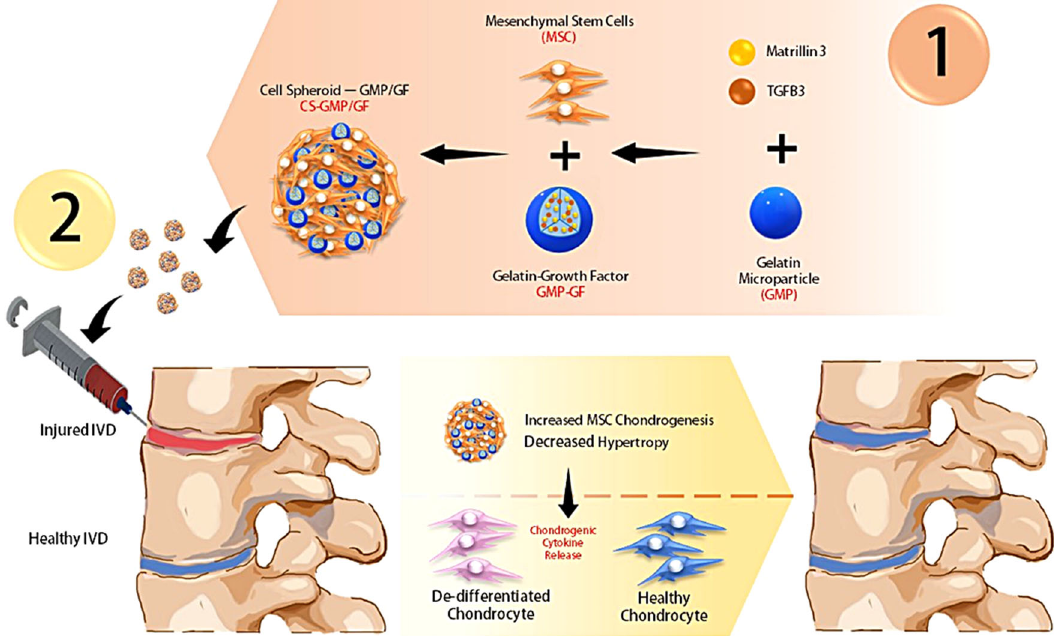
Fig. 1 Research summary. Incorporation of TGFB3 and Matrilin-3-loaded gelatin microparticle (GMP) in ASC spheroids enhances chondrogenic differentiation of cells, inhibits hypertrophy, and promotes the secretion of chondrogenesis-enhancing cytokines that are essential for the regeneration of degenerated cells in intervertebral disc